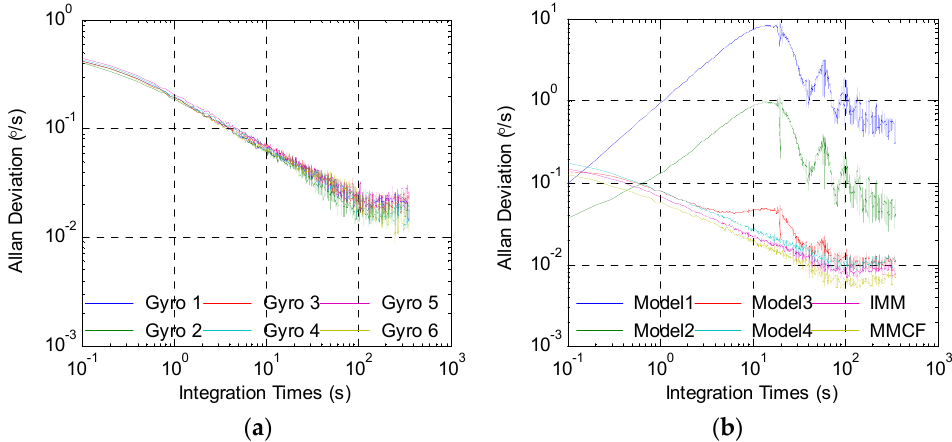
Figure 11. The Allan deviation test results: ( a ) The Allan deviation of the errors from individual gyroscopes; ( b ) the Allan deviation of the errors from the gyro array. Table 3. The overall results of the gyro array. IMM: Interacting multiple model; RMSE: Root mean